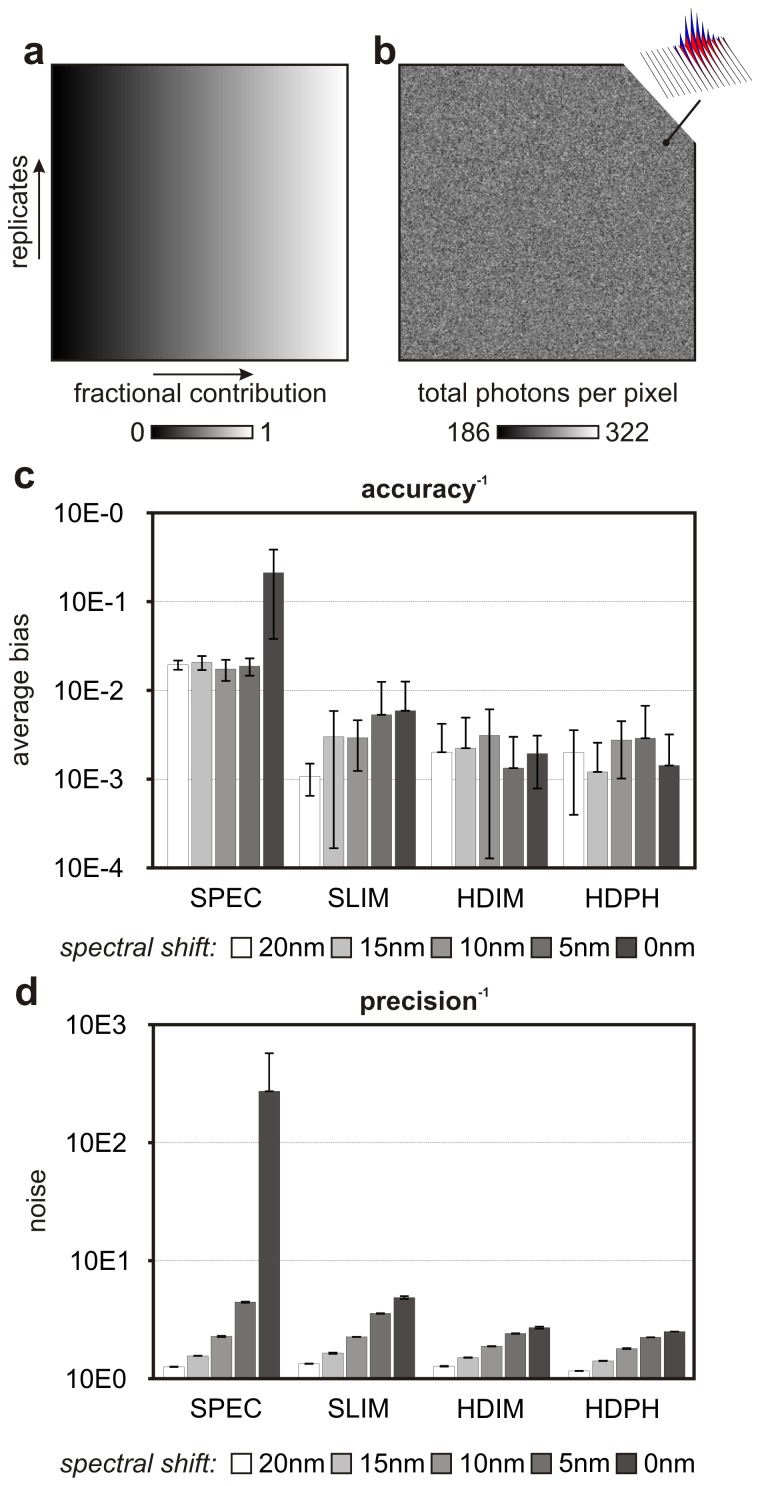
Accuracy and precision of unmixing based on hyper-spectral imaging (SPEC), spectrally resolved FLIM (SLIM) and HDIM.HDIM data was also analyzed with a generalized phasor transform (Hyper-dimensional Phasors, or HDPH). A linear gradient (a) of relative fractional contribution of two fluorophores was used to mix the optical signatures shown in Fig. S1 and illustrated in the inset of panel b. Simulations were carried out in the presence of Poissonian noise with expected count per pixel equal to 250 (shown in b), 1,000 and 10,000 photons. The difference between the simulated fractional contributions and the values estimated by spectral unmixing was used to compute the bias of various techniques (c). The vertical direction of these synthetic images was used to estimate statistical errors caused by Poissonian noise and, therefore, the precision of the analysis techniques (d). Accuracy and precision are shown for fluorophores with spectral peaks at various spectral shifts from each other (0 nm, 5 nm, 10 nm, 15 nm and 20 nm) around the central wavelength of 550 nm. The error bars in panel (c–d) show standard deviations computed across simulations at different noise photon count levels.